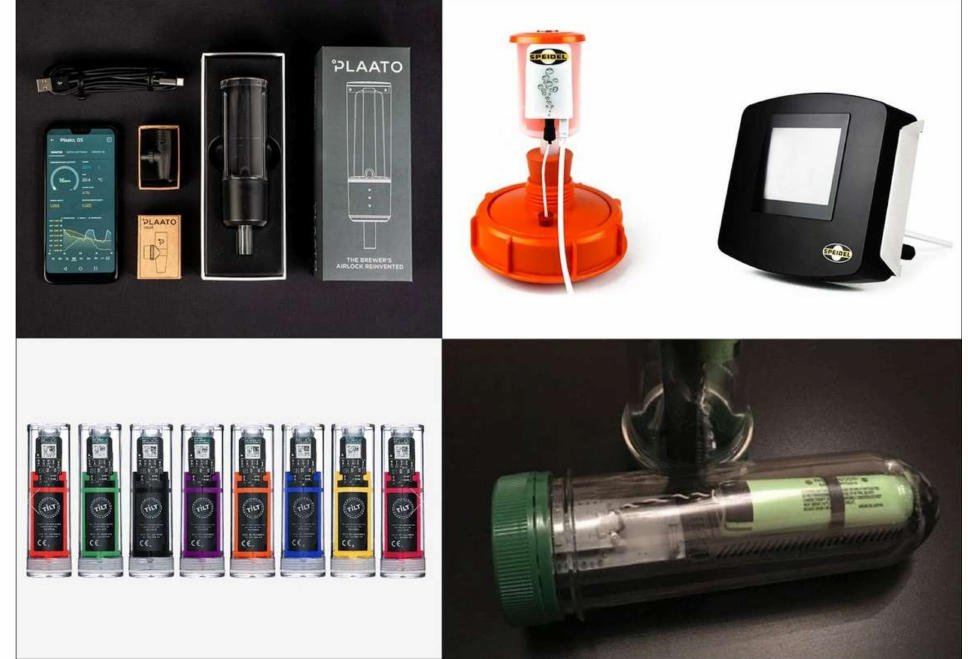
Figure 3. Devices. Top left —Plaato Airlock (image source: https: // plaato.io / products / plaato-airlock)); Top right —Speidel GÄRSPUNDmobil (image source: https: // www.speidels-braumeister.de / en / braumeister / gaerspundmobil-and-gaermeister-control.html); Bottom left —Tilt Hydrometer (image source: https: // tilthydrometer.com / ); Bottom right —iSpindel DIY electronic Hydrometer (http: // www.ispindel.de /